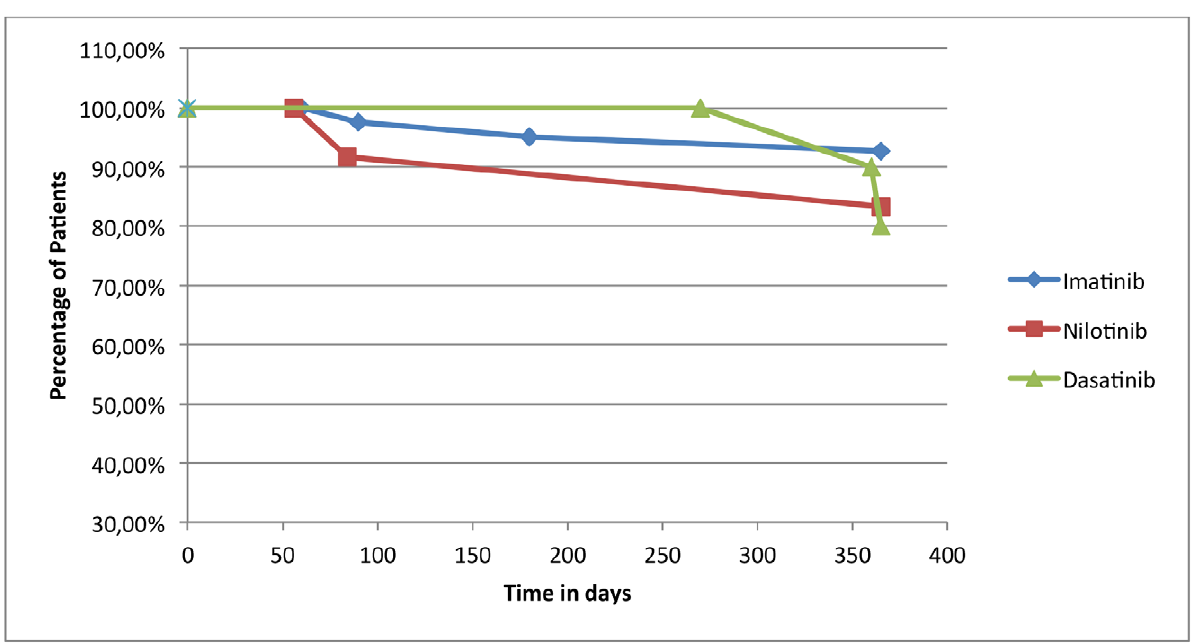
Figure 2. Kaplan Meier Representation of Persistence to one year of therapy with Imatinib, Nilotinib and Dasatinib.